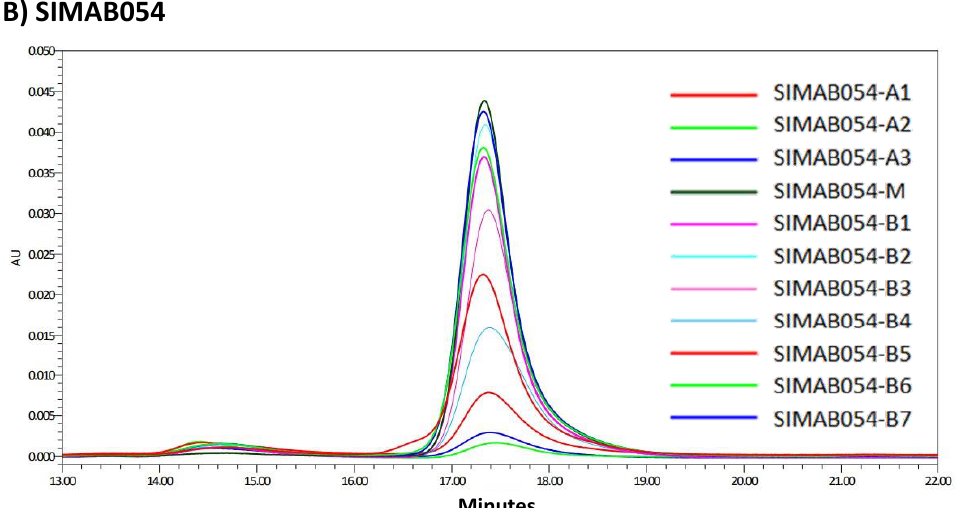
Figure 3. SEC-HPLC analysis results of each fraction. ( A ) Overlay chromatograms of AVT08 charge variant fractions. ( B ) Overlay chromatograms of SIMAB054 charge variant fractions.